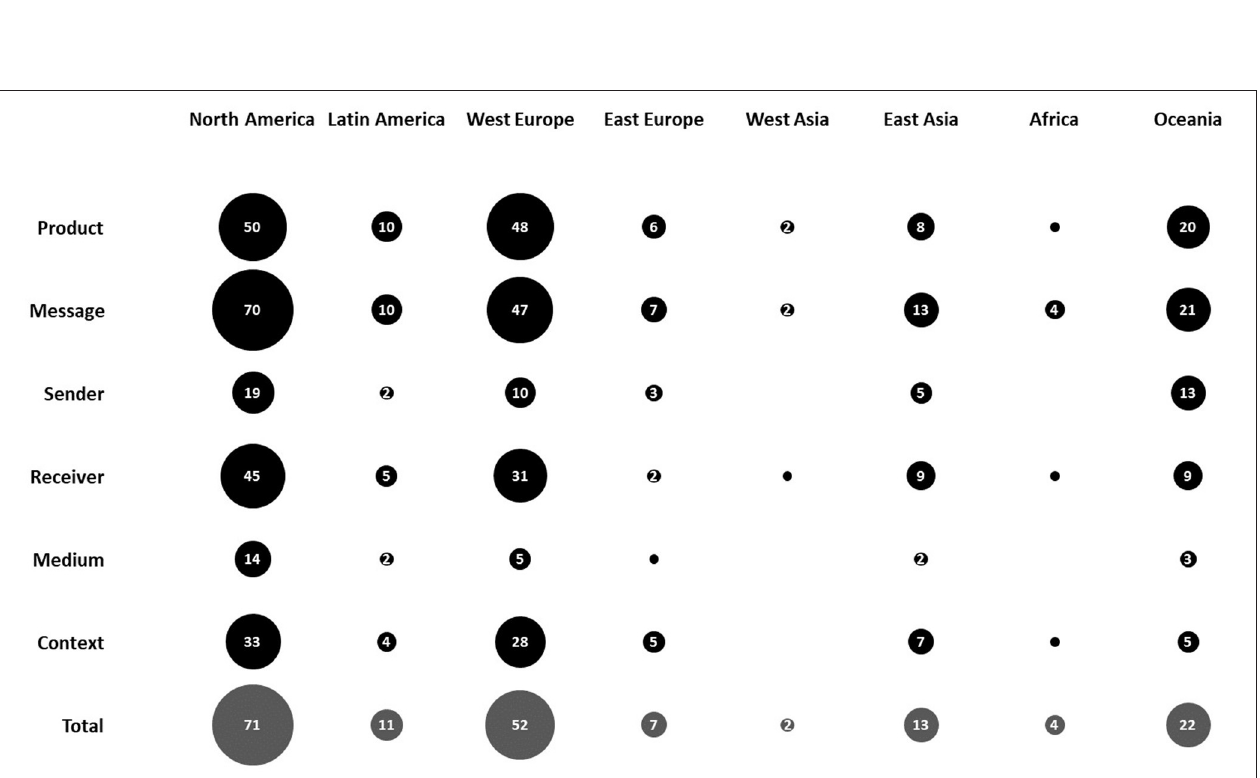
FIGURE 7 | Prevalence of empirical studies in each geographical region (i.e., North America, Latin America, West Europe, East Europe, West Asia, East Asia, and Oceania) related to each element (i.e., product, message, sender, receiver, medium, and context) and in total. Numbers in bubbles specify the prevalence. Note that bubbles with no number represent only one